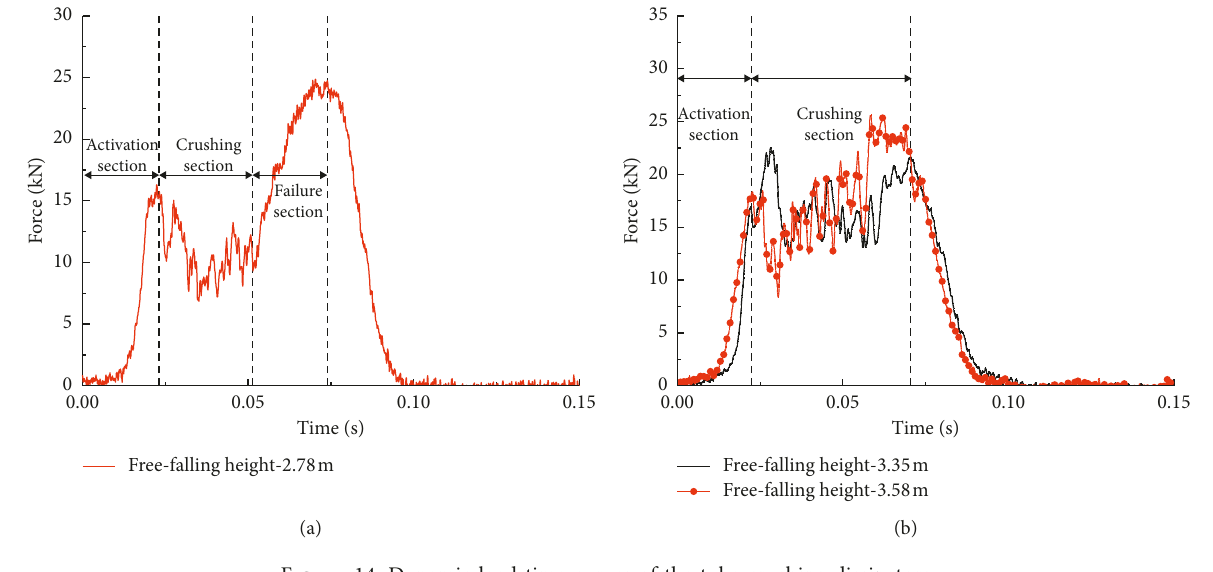
Figure 14: Dynamic load-time curves of the tube-crushing